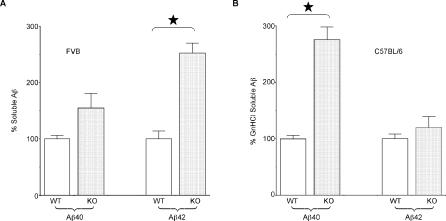
Increased Aβ40 and Aβ42 Levels in fmr-1 KO Mice(A) Soluble brain lysates from 1-y-old WT and fmr-1 KO mice (FVB strain) analyzed by ELISA and plotted as a percentage of soluble Aβ compared to WT controls. Student t-tests: p = 0.06 (Aβ40) and p = 0.001 (Aβ42).(B) GnHCl-soluble brain lysates from 1-y-old WT and fmr-1 KO mice (C57BL/6 strain) analyzed by ELISA and plotted as a percentage of GnHCl-soluble Aβ compared to WT controls. Student t-tests: p < 0.001 (Aβ40) and p = 0.39 (Aβ42).